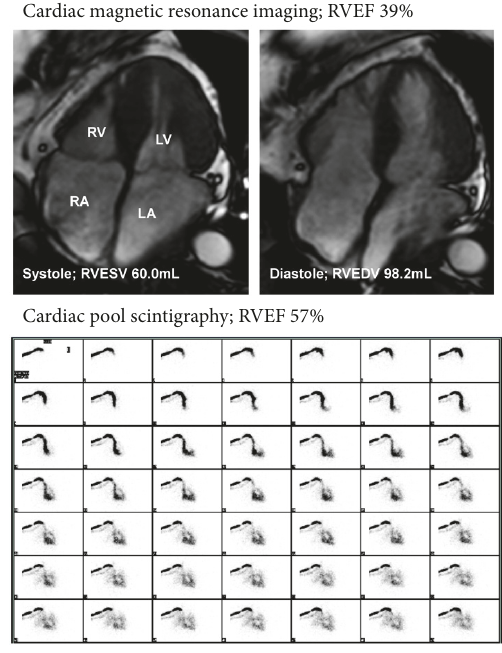
Figure 2: Cardiac magnetic resonance imaging and cardiac pool scintigraphy demonstrating reduced right ventricular ejection frac- tion (39% and 57%, resp.). RV: right ventricular; LV: left ventricular; RA: right atrium; LA: left atrium; ESV: end-systolic volume; EDV: end-diastolic volume; RVEF: right ventricular ejection